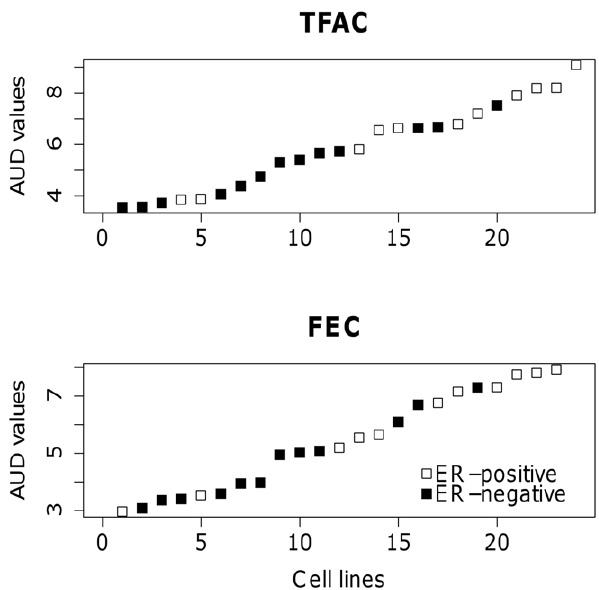
Figure 1. Chemoresponse-derived AUD values for each cell line, labeled by ER status, for both TFAC (top) and FEC (bottom) treatments.